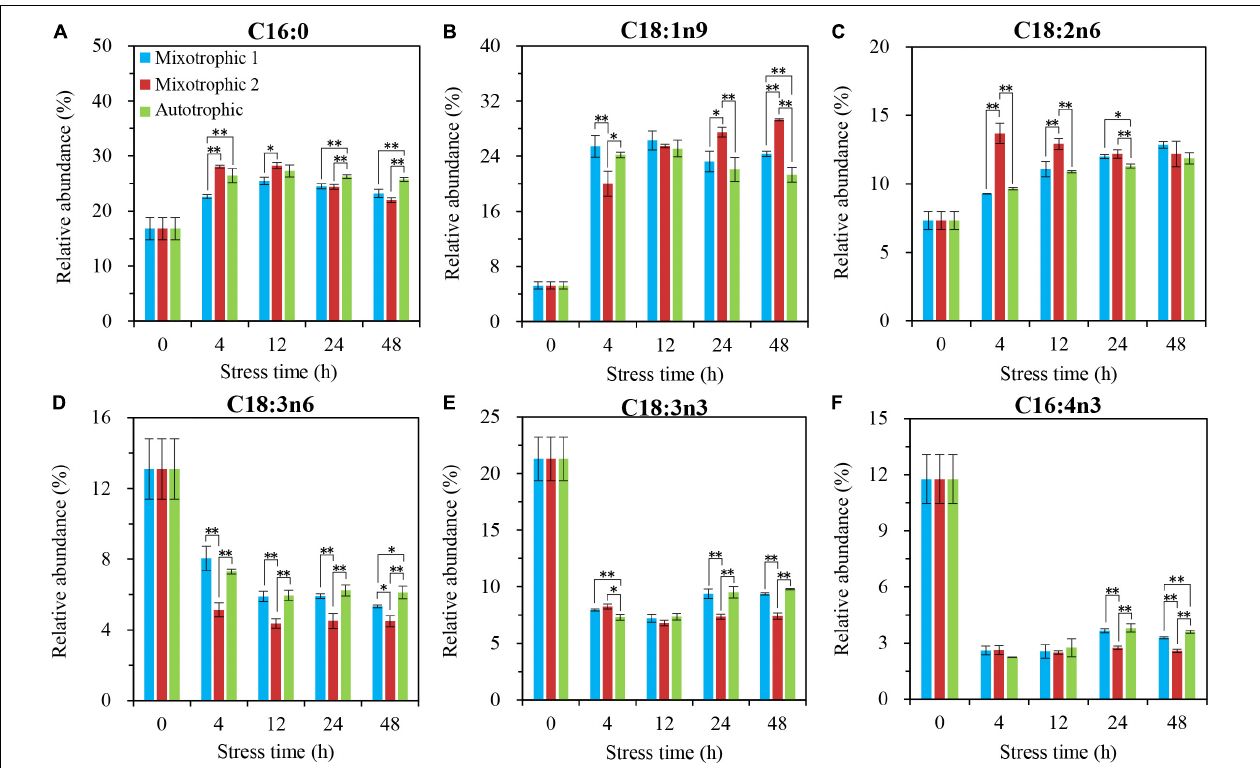
FIGURE 7 | Time course of changes in the relative abundances of the major fatty acyls in TAG of C. reinhardtii BAFJ5 under three carbon supply regimes over 48 h of HL-N. The carbon supply regimes for mixotrophic 1, mixotrophic 2, and autotrophic were 17 mM acetate and 2% CO 2 (v/v), 17 mM acetate and ambient 0.04% CO 2 (v/v), and 2% CO 2 (v/v), respectively. Cx:ynz, where x, y, and z refer to the number of carbon, the number of double bonds, and the position of the first double bond counting from the methyl end, respectively. Values are the means of three independent replicates ± SD ( n = 3). ∗ p < 0.05; ∗∗ p <